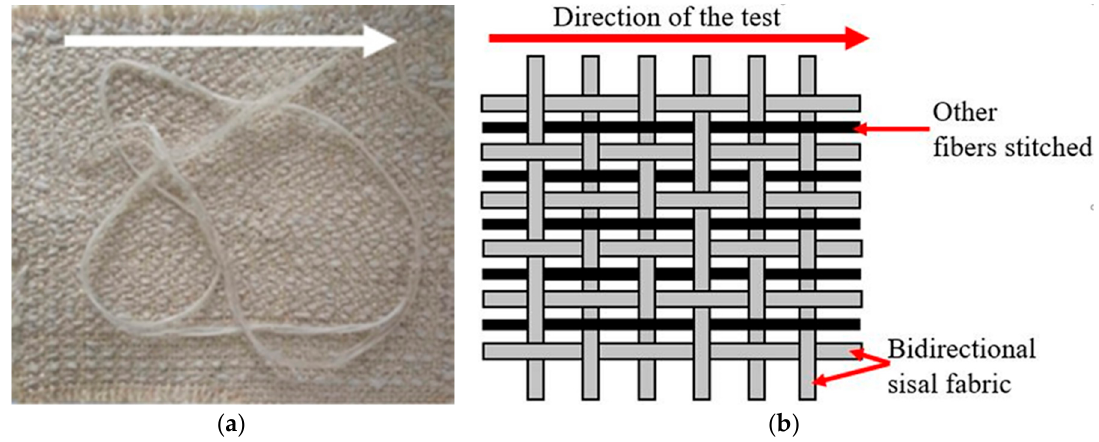
Figure 1. ( a ) Bidirectional sisal fabric and ( b ) schematic drawing of intralaminar